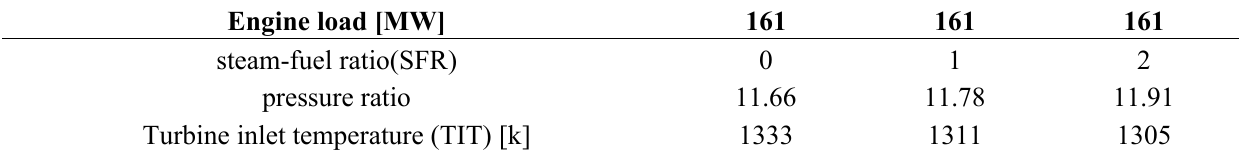
Table 1. Dry engine vs. steam injected engine